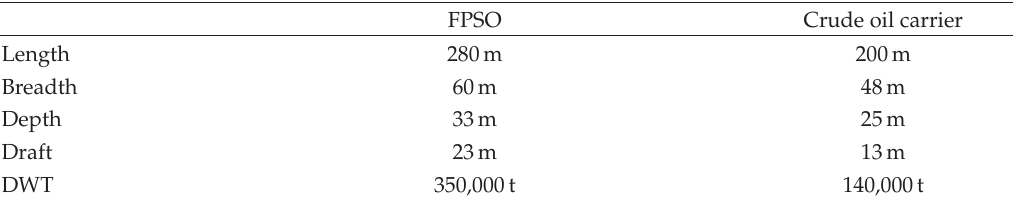
Figure 11: Struck ship damage postprocessing of finite element and SHARP simulations. Table 1: Ships main